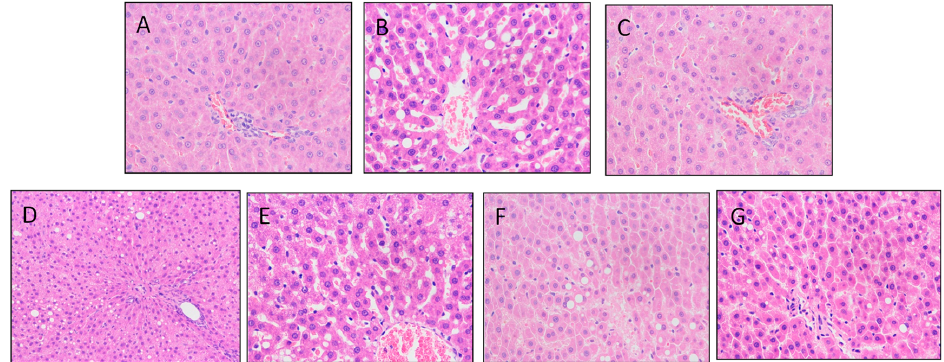
Figure 3. HE staining slice of liver tissues (400×). ( A ), normal control (NC); ( B ), model control (MC); ( C ), positive control (PC); ( D ), Mulberry leaf powder (MLP); ( E ), Mulberry leaf fiber (MLF); ( F ), Mulberry leaf polyphenols group (MLPS); ( G ), Mulberry leaf fiber/polyphenols mixture (MLM).